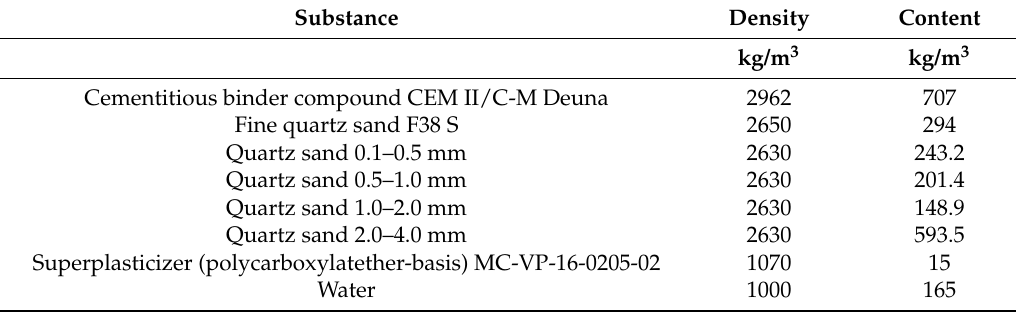
Table 3. Mix design of cementitious matrix for HF-2-165-4 (mix design adapted from [70]).